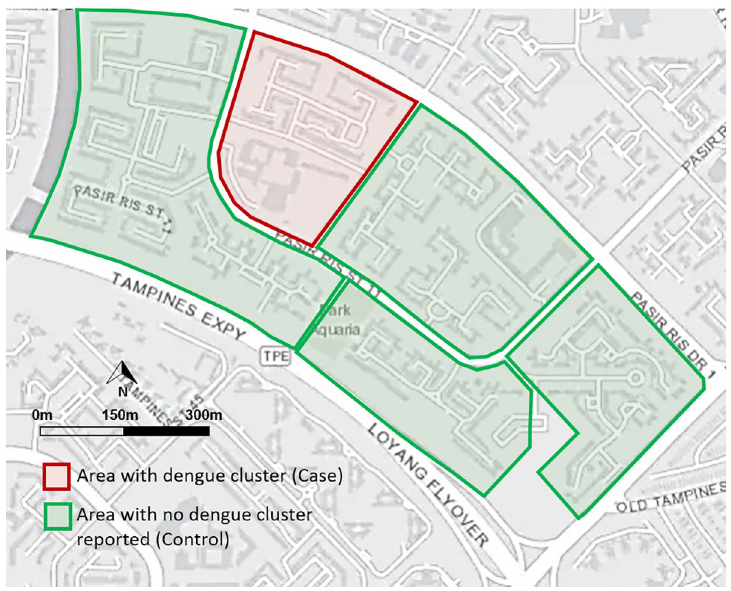
Fig 2. Map showing an example of a case (red) and controls (green). The figure was created with base layer obtained from